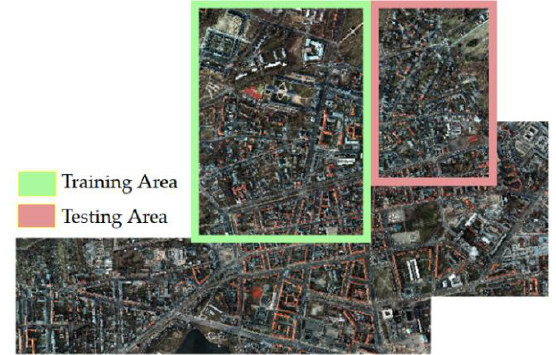
Figure 7. Overview of training and testing datasets